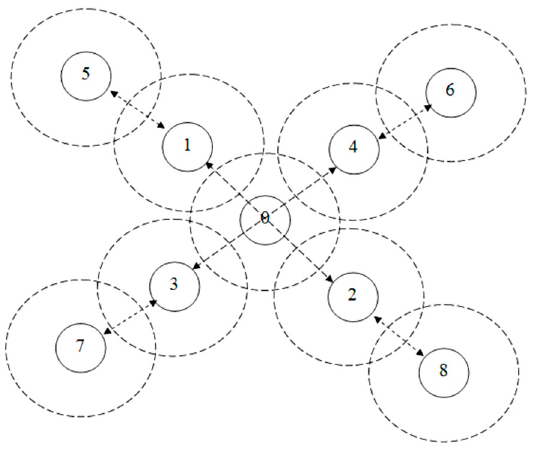
Figure 1. A mobile ad hoc network (MANET) topology illustrating the problem of network segregation.